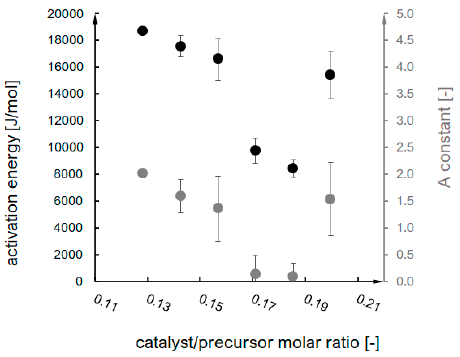
Figure 3. Designated values of E a and A constant as catalyst/precursor molar ratio function.